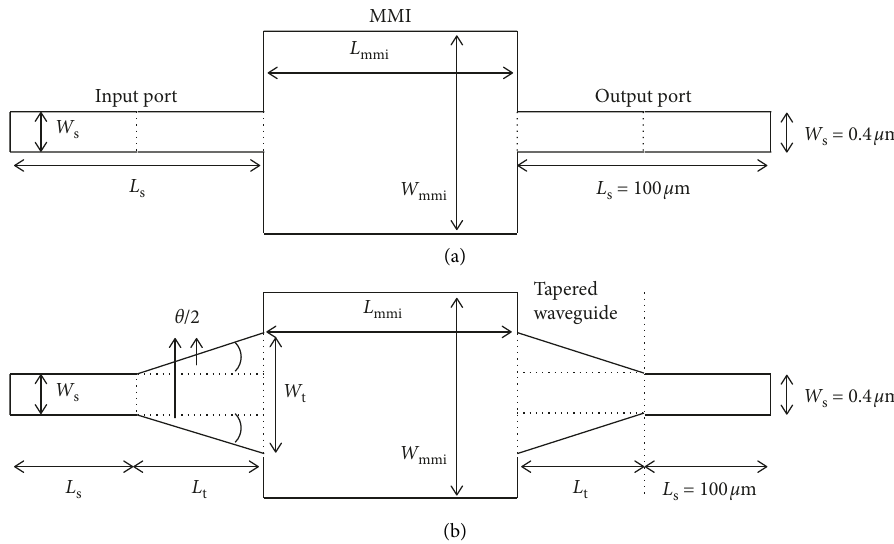
Figure 2: (a) A basic 1 × 1 MMI combined with the input/output single-mode waveguide for width W (b) A linear tapered waveguide is inserted between the single-mode waveguide and MMI coupler. Width W t , length L t , and divergence angle θ describe the linear tapered waveguide.